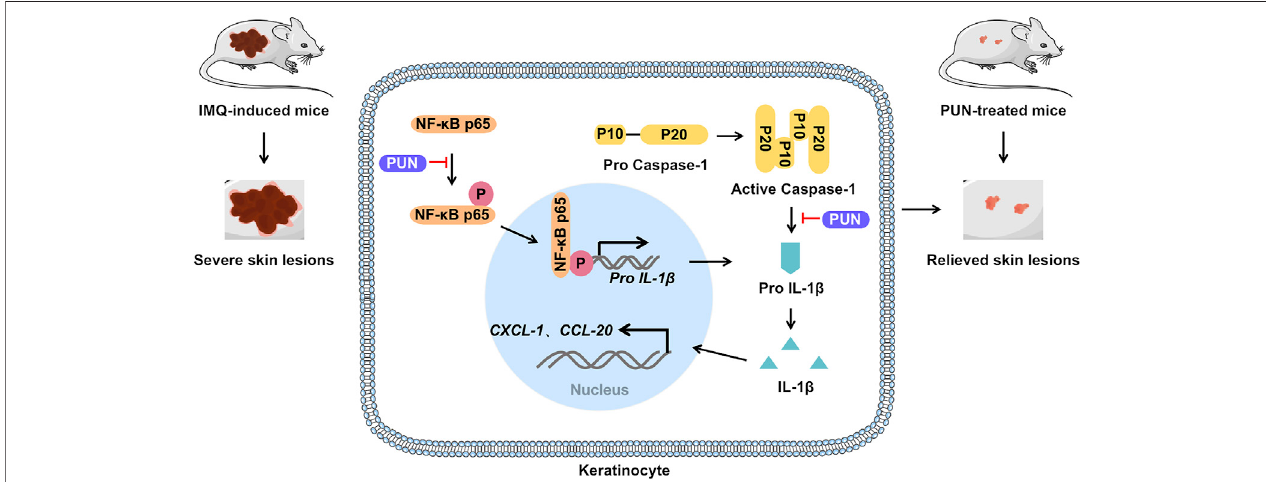
FIGURE 4 | Punicalagin alleviates psoriasis by inhibiting NF- κ B-mediated IL-1 β transcription and caspase-1-regulated IL-1 β secretion. Punicalagin relieves psoriasis by inhibiting NF- κ B activation and cleaved caspase-1 expression, which ultimately suppresses the transcription and secretion of IL-1 β and consequently represses IL-1 β -mediated in fl ammatory cascade in vitro and in vivo